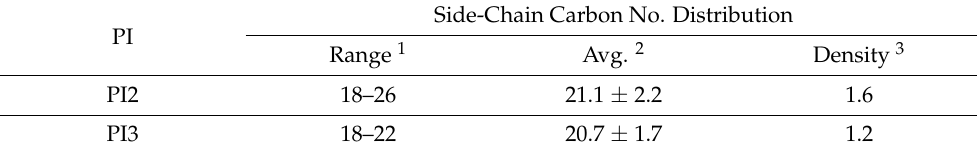
Table 2. Paraffin inhibitor (PI) composition and properties.